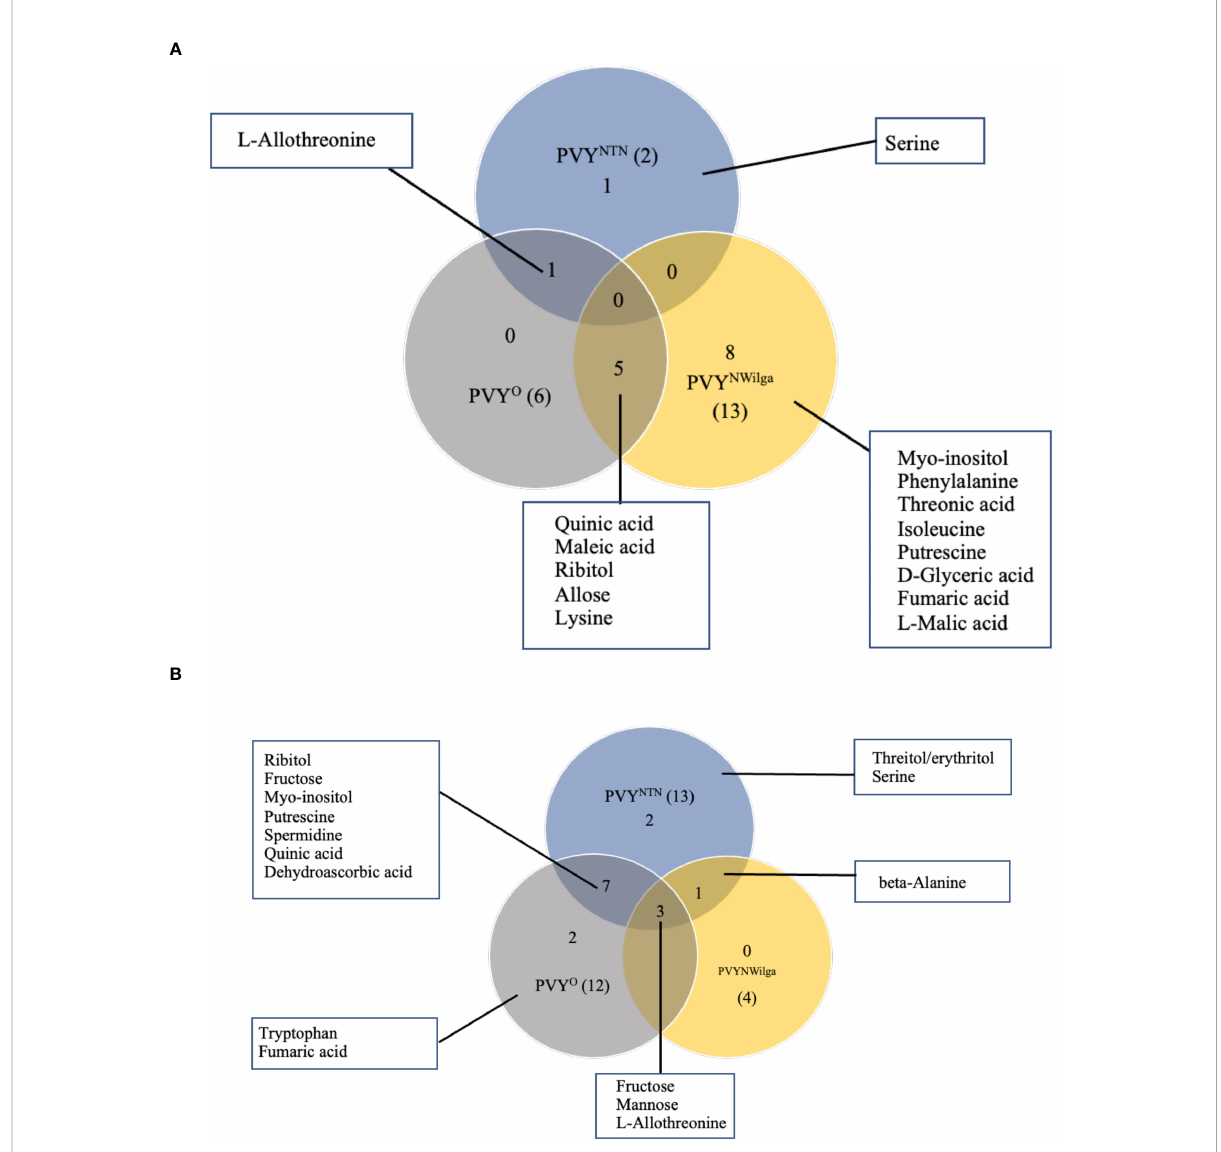
FIGURE 1 Distribution of metabolites that are changed or differentially accumulated following infection by potato virus Y. (A) Differentially accumulated metabolites (DAMs) detected in (A) Premier Russet, and (B) Russet Burbank. Numbers in parentheses denote the total DAM number induced by each PVY strain. A fold-change threshold >1.5 and FDR p -values < 0.05 was